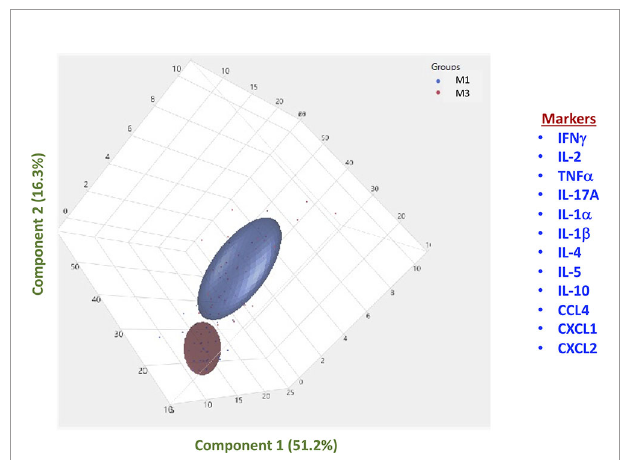
FIGURE 4 | PCA analysis to estimate the discriminatory power of immune markers in Covaxin vaccinated individuals before and after vaccination. PCA (Principal component analysis) plot computing normalized ELISA data from plasma levels of selected cytokines and chemokines in vaccinated individuals at baseline [M0], before vaccination (Coloured in blue) vs month 3 [M3] following vaccination (Coloured in